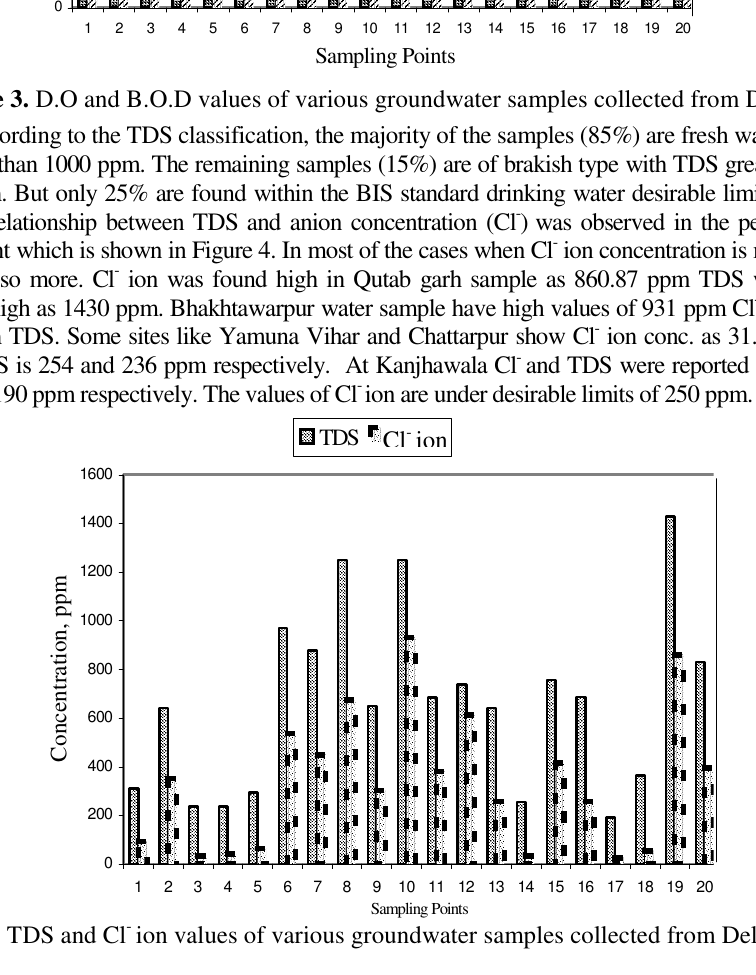
Figure 4 . TDS and Cl - ion values of various groundwater samples collected from Delhi.